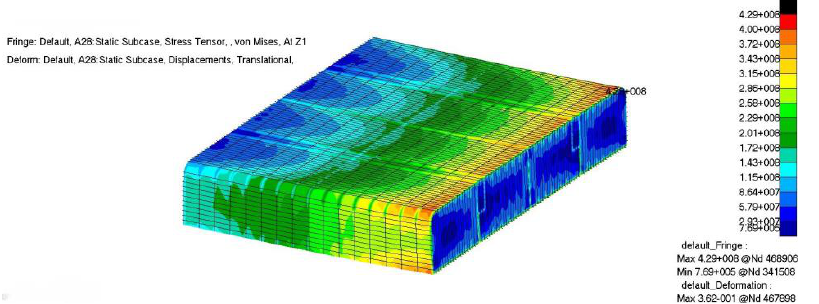
Figure 26. Stress cloud diagram of the bottom outer plate of the 4th and 5th cabins at the high tide of the ship on the day of the incident.